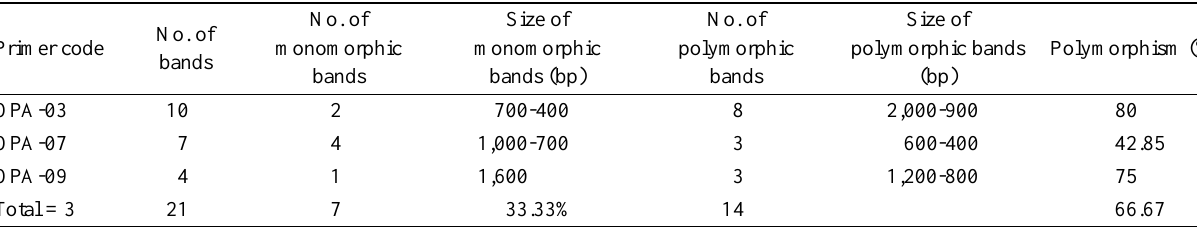
Figure 3. RAPD profiles using primer OPA-09. ‘a’ is monomorphic for all experimental Table 2. List of primers and their monomorphic and polymorphic bands